Question: Provide a one-line summary of what is displayed.
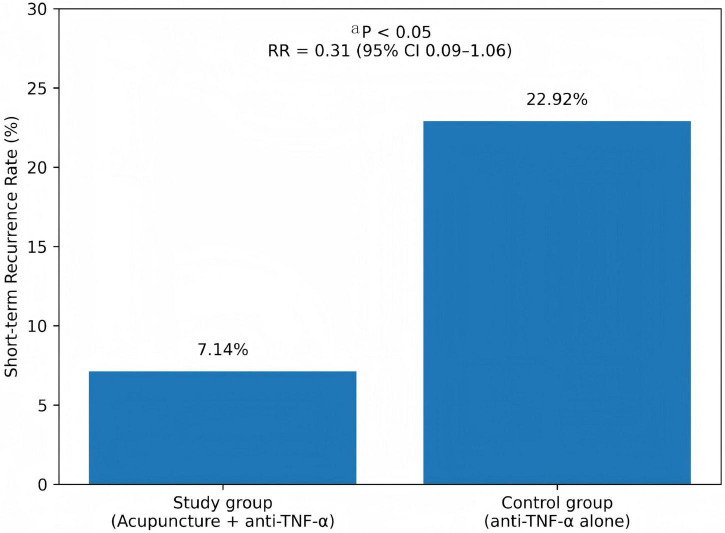
Answer: Comparison of short-term recurrence rate between the two groups (follow-up from week 12 to month 6). a P < 0.05 vs. control group, RR = 0.31, 95% CI: 0.09–1.06.